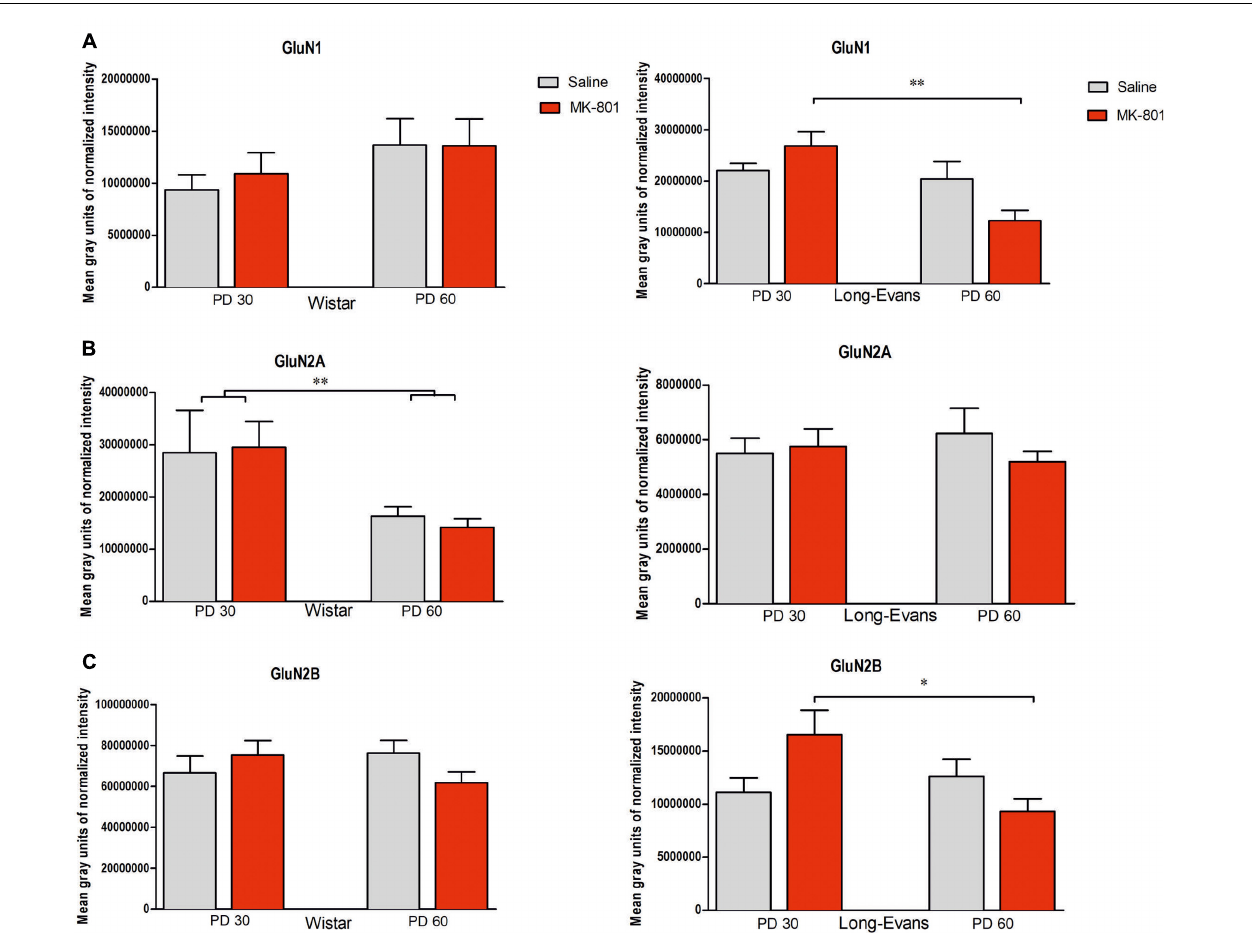
FIGURE 5 | Expression of NMDA subunits in the hippocampus: (A) GluN1 subunit, (B) GluN2A subunit (C) GluN2B subunit: The charts show the two intervals of the start of administration (PD 30 and PD 60). Strains of rats are marked as Long-Evans (LE) and Wistar (W). The data show the mean level of chemiluminescence after total protein normalization (group means ± SEM). # P < 0.05 compared to controls of the same strain and age. ∗ P < 0.05, ∗∗ P < 0.01; comparison between age